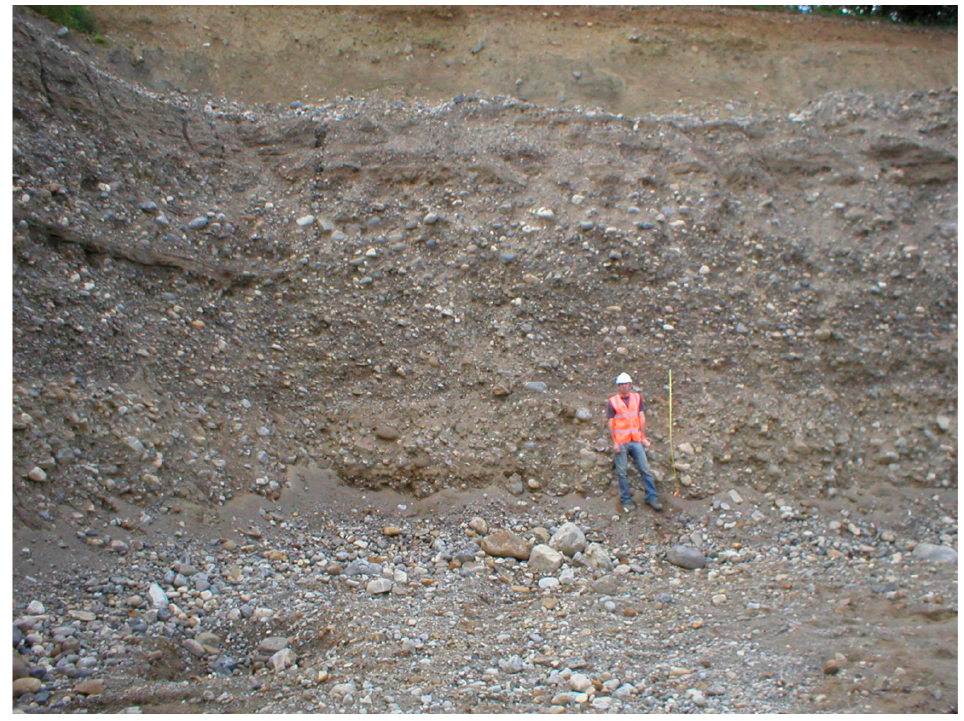
Figure 2. Exposures of fluvioglacial outwash gravels exposed in the southeastern part of Marfield Quarry (photo 2004 by David Bridgland), with David Roberts shown as scale. The gravel sequence is capped by a thin surface till, indicating a brief period of local Wensleydale ice re-advance. Table 3. Lithostratigraphy at Nosterfield, the Flasks 69. Altitude 39.26 m a.s.l.